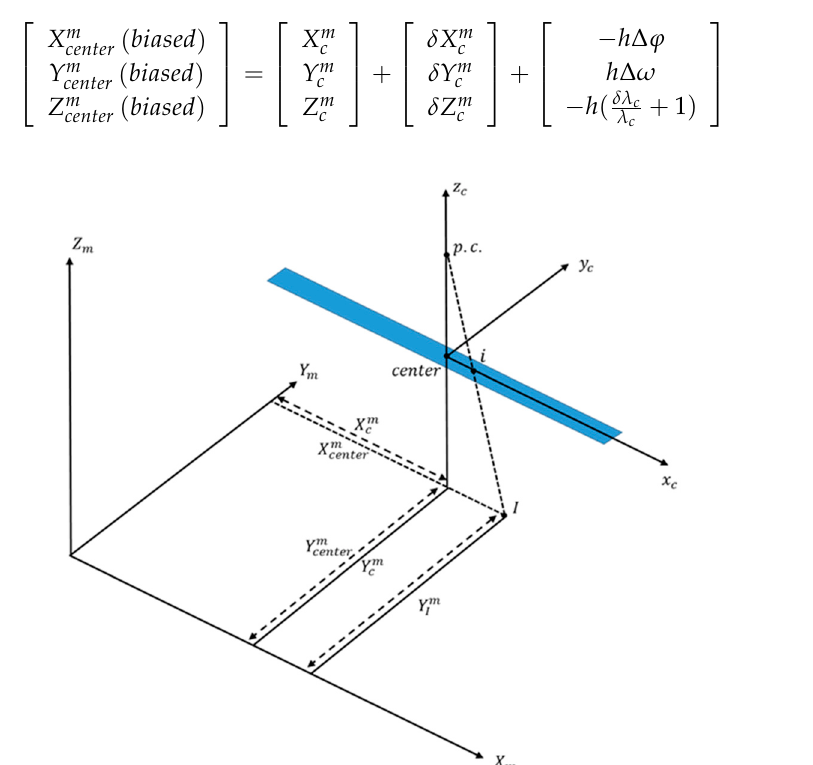
Figure 7. Imaging geometry of a nadir-looking vertical push-broom hyperspectral scanner.